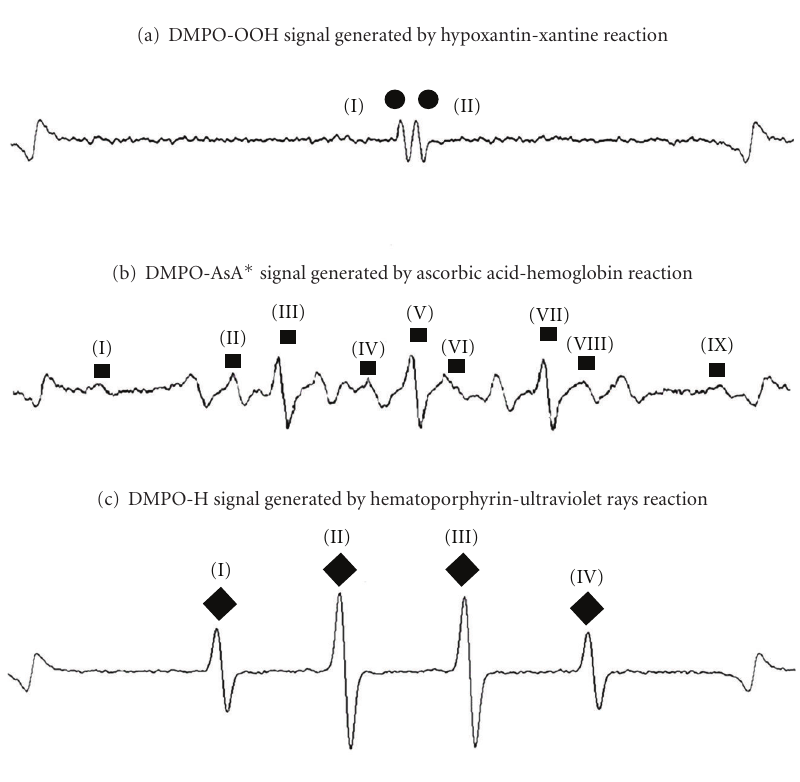
Figure 1: Standard ESR signals of DMPO- and